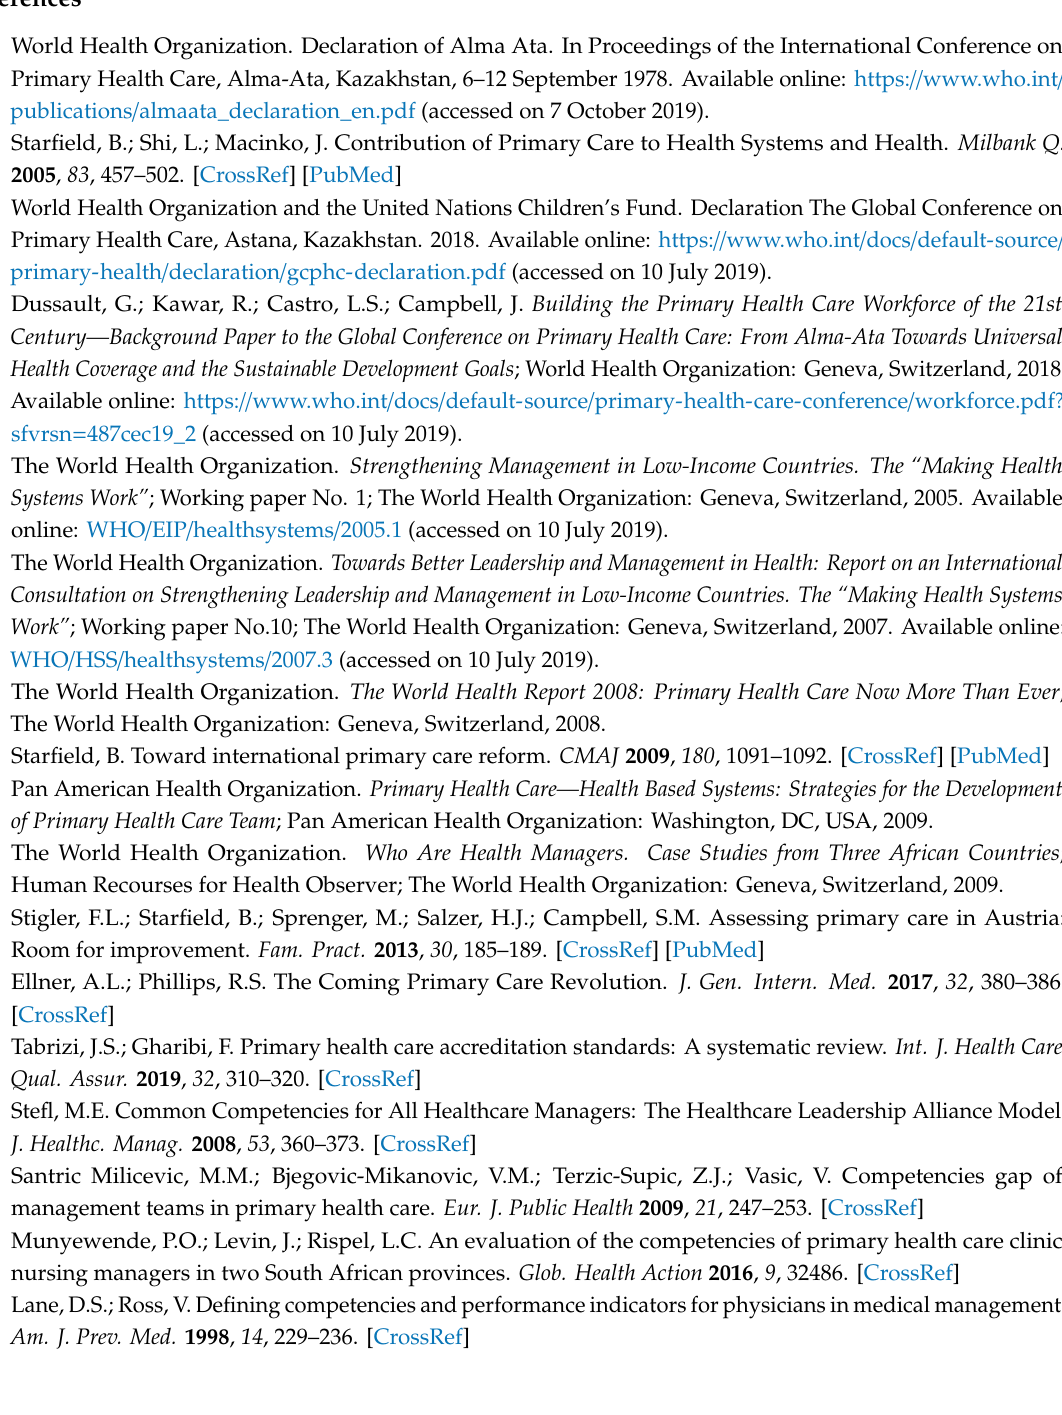
Table S1: Serbian version of